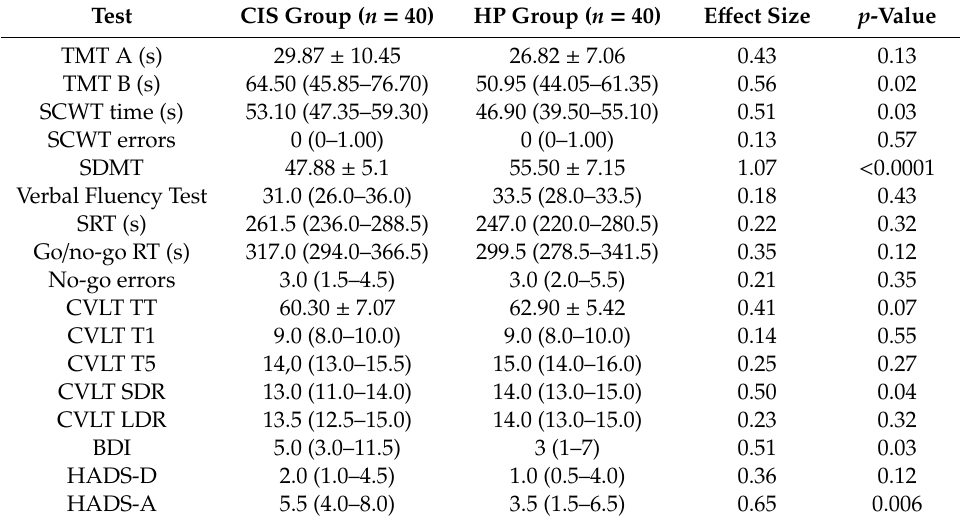
Table 2. Di ff erences in cognitive test results and BDI and HADS in CIS and HP